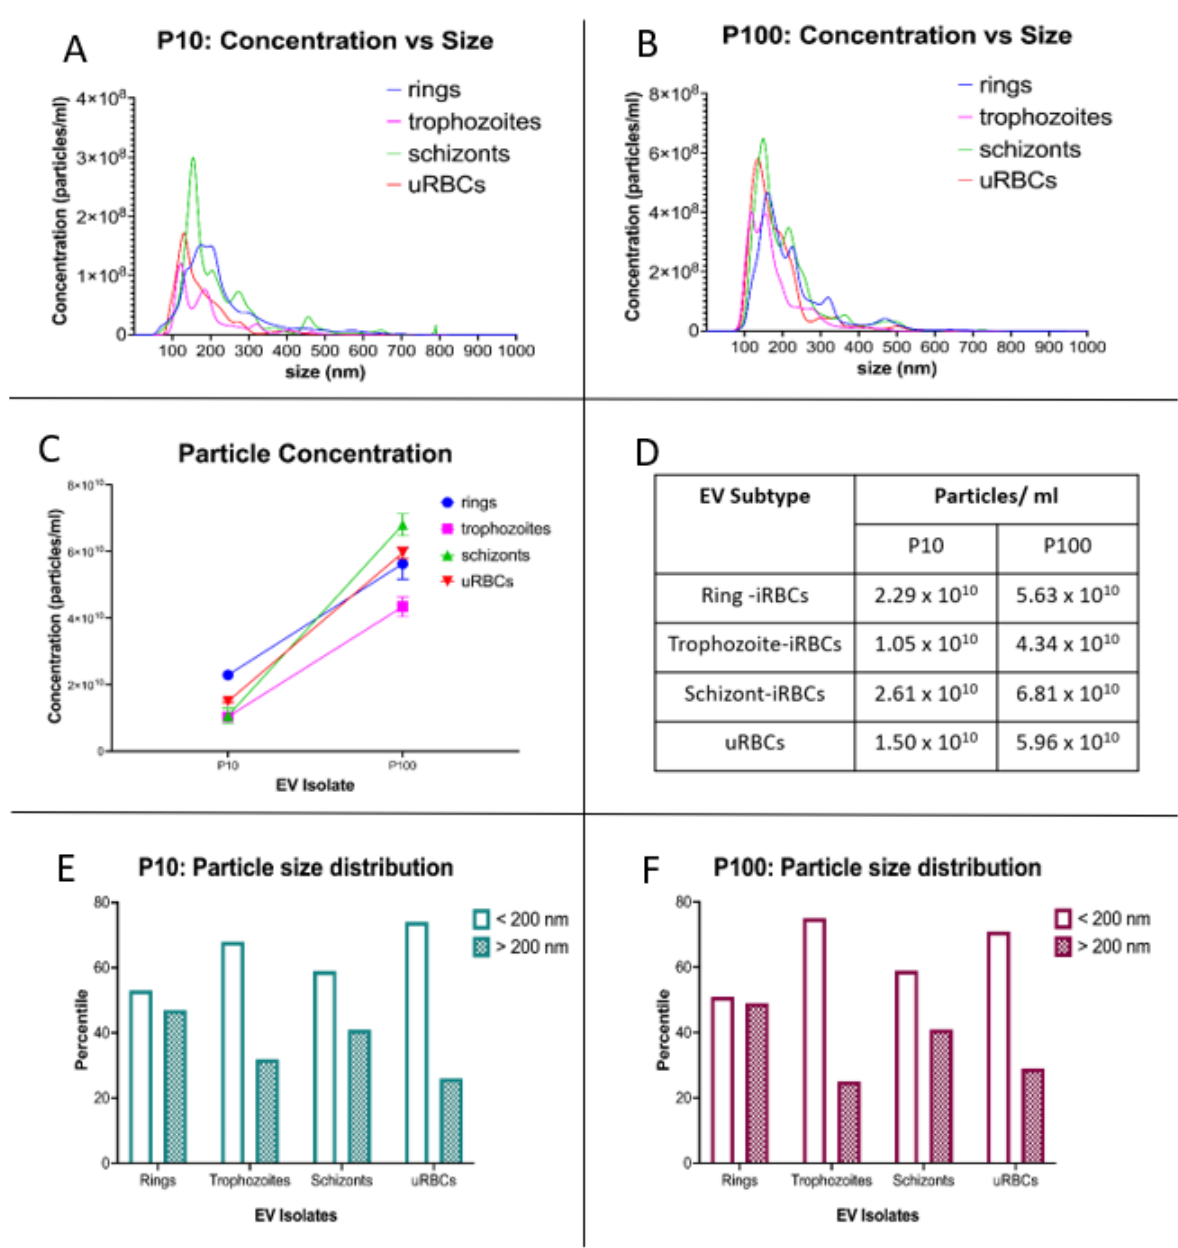
Figure 4. NTA of P. falciparum iRBC EVs and uRBC EVs. Particle concentration and size distribution